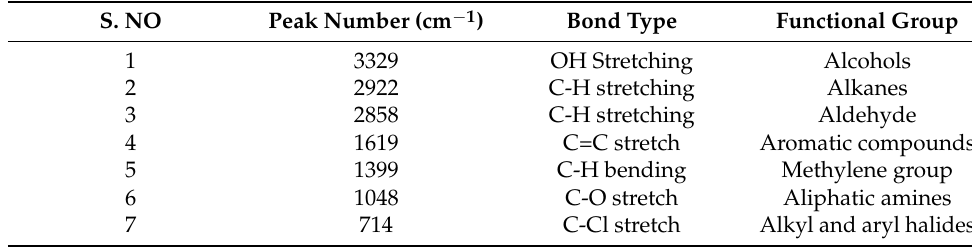
Figure 5. The FT-IR spectra of ( a ) Urtica dioica (UD), ( b ) Capsella bursa-pastoris (CBP), and ( c ) Inula racemosa (IR) with a scan range of 400–4000 cm − 1 . Table 2. FT-IR spectral data of the ethanolic extract of U. dioica .